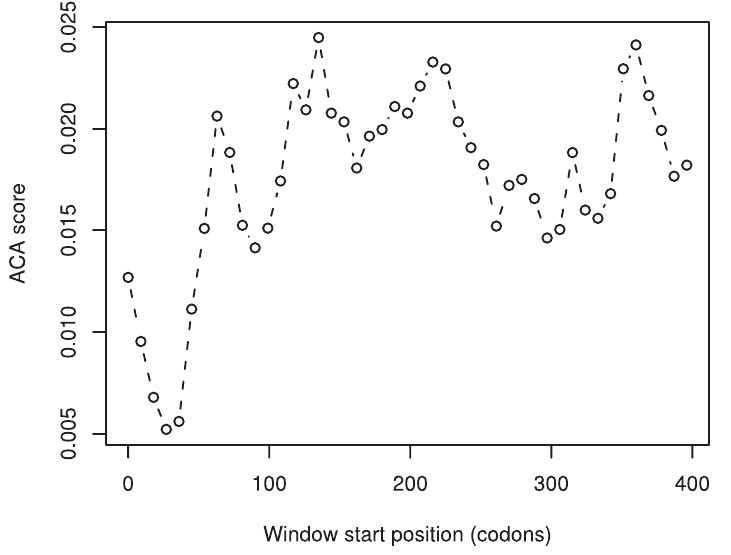
Figure 2. The sliding window profile of FOXF2: a lung and placenta specific transcription factor. Although there is large variation across the gene, the ACA score at the 5 9 region is very unlikely to have occurred by chance (P , 0.001).